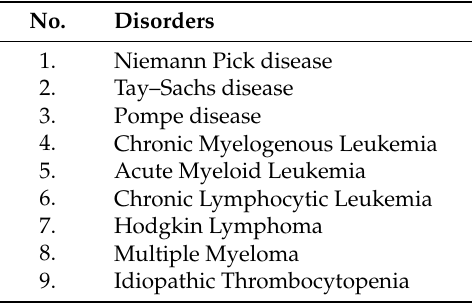
Table 1. Disorders to be Considered in the Differential Diagnosis of Gaucher Disease (GD).